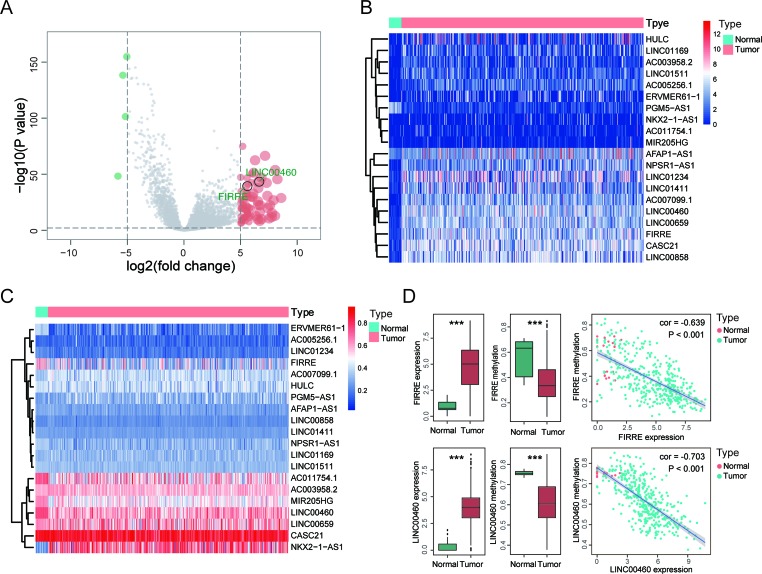
Epigenetic landscape of long noncoding RNAs (lncRNAs) in colorectal cancer (CRC) revealed LINC00460 as a candidate gene. (A) Volcano of 75 different expressed lncRNAs between tumor and adjacent normal tissues from The Cancer Genome Atlas (TCGA) database. Heatmap of 20 lncRNAs which contained both expression (B) and methylation (C) data. (D) Pearson correlation between expression and methylation of two hypomethylated lncRNAs (LINC00460 and FIRRE). ***p < 0.001.